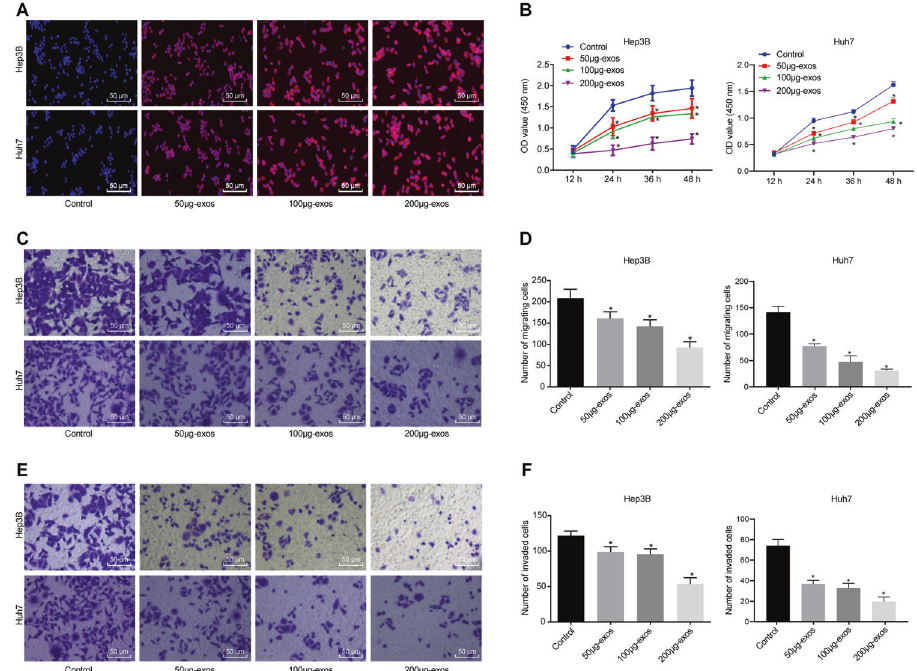
Fig. 2 MSC-derived exosomes repress proliferation, migration, and invasion of HCC cells in vitro. A Uptake of MSC-derived exosomes from Hep3B and Huh7 cells was observed under a laser confocal microscope (×200). B Effect of exosomes on the proliferation of Hep3B and Huh7 cells was detected by CCK-8 assay. C Effect of exosomes on the migration of Hep3B cells and Huh7 was detected by transwell assay (×200). D Statistical analysis of panel C . E Effect of exosomes on the invasion of Hep3B and Huh7 cells was detected by transwell assay (×200). F Statistical analysis of panel E. p <0.05 vs. control cells. Data in panel B were analyzed by repeated-measures ANOVA with Bonferroni post hoc testing, and in panels, D and F were analyzed by one-way ANOVA followed by Tukey ’ s post hoc test. Data are shown as mean ±standard deviation of three technical